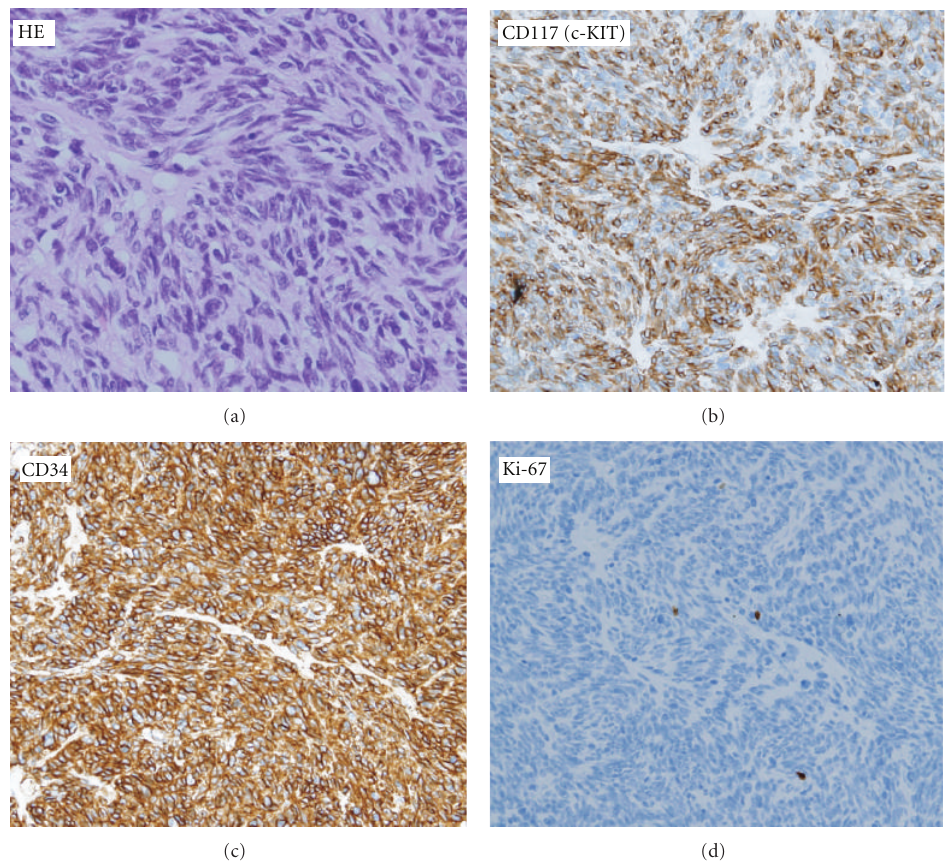
Figure 4: Histopathological analysis of the tumor: (a) HE, (b) CD117, (c) CD34, and (d)